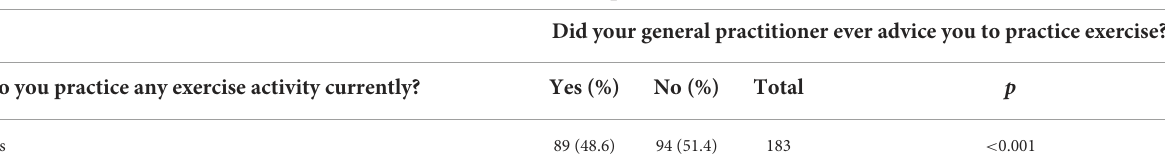
TABLE 2 General practitioner advice, exercise practice, and motivation to start a new exercise program among those who did not practice exercise. GP’s advice and exercise practice ( n =